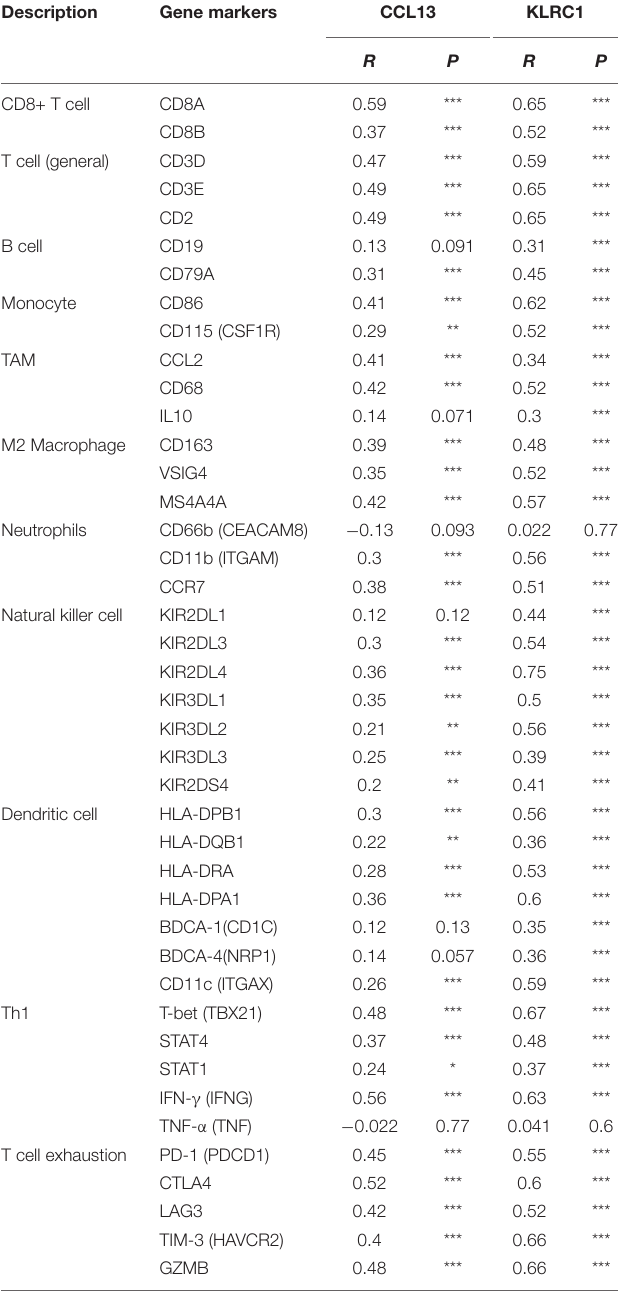
TABLE 4 | Correlation analysis between two hub genes and immune cells markers in